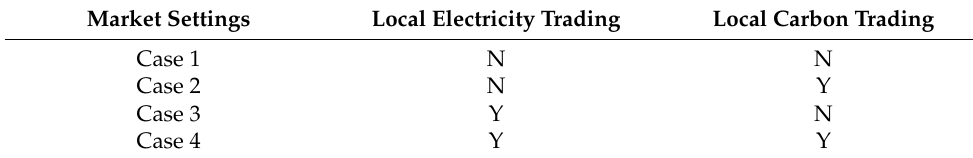
Table 2. Local market settings (Y: Yes; N: No).